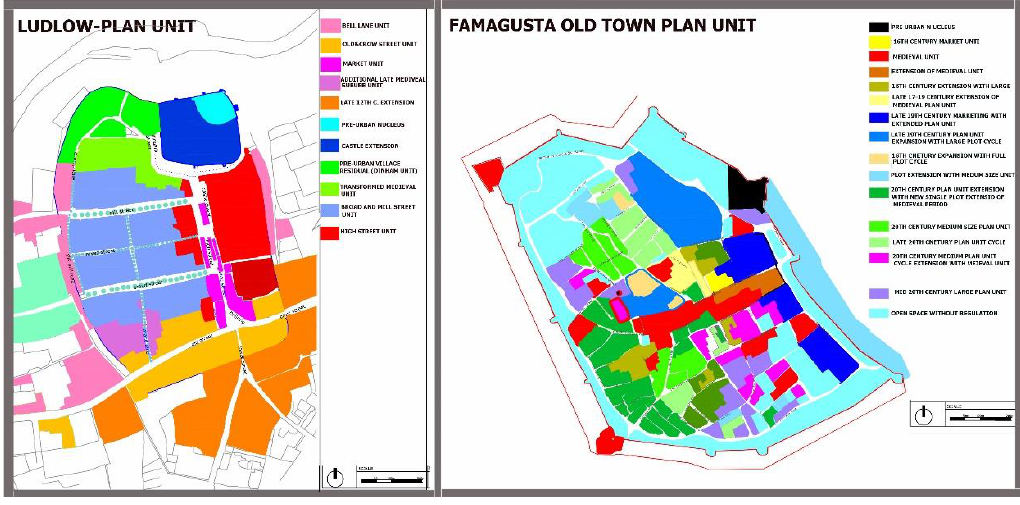
Figure 7 Ludlow and Famagusta Plan